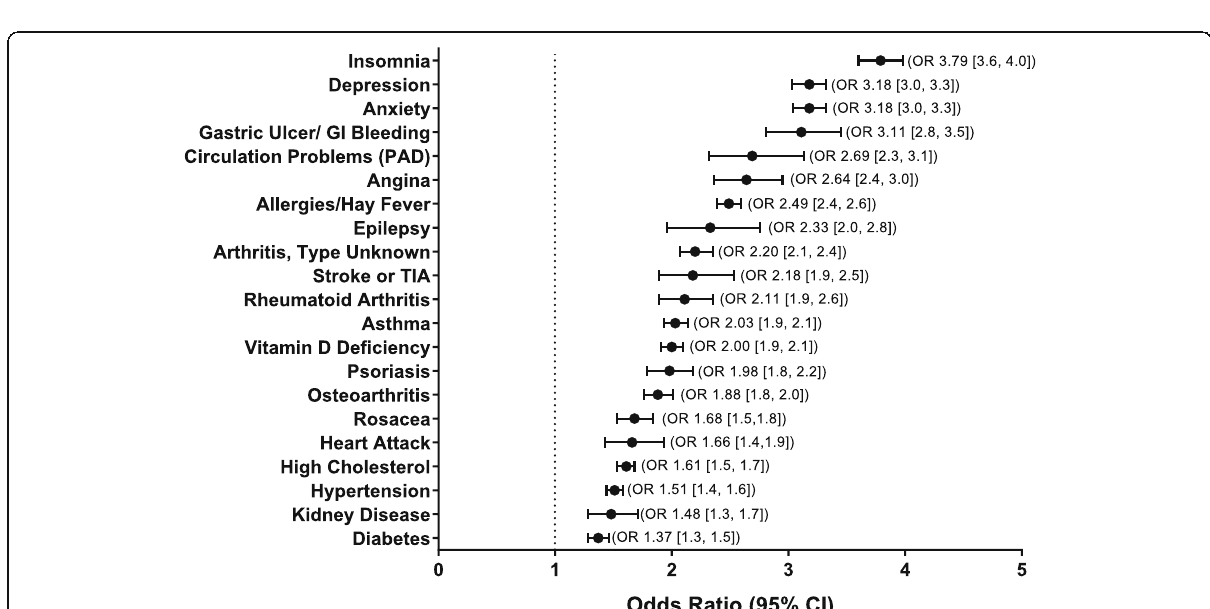
Fig. 1 Relative odds of migraine (and 95% CI) vs. migraine free controls for each comorbid condition*. *Adjusted for sociodemographic characteristics (age, gender, Hispanic origin, race, marital status, employment, household income). Reference group is the non-migraine cohort. GI = gastrointestinal; OR = odds ratio; TIA = transient ischemic